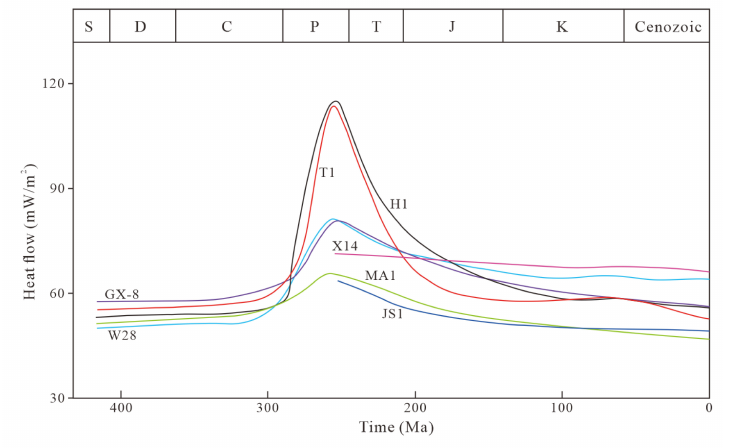
Figure 9. The heat flow evolution history since the Late Silurian of representative boreholes in the Sichuan Basin (according to Jiang et al., 2018